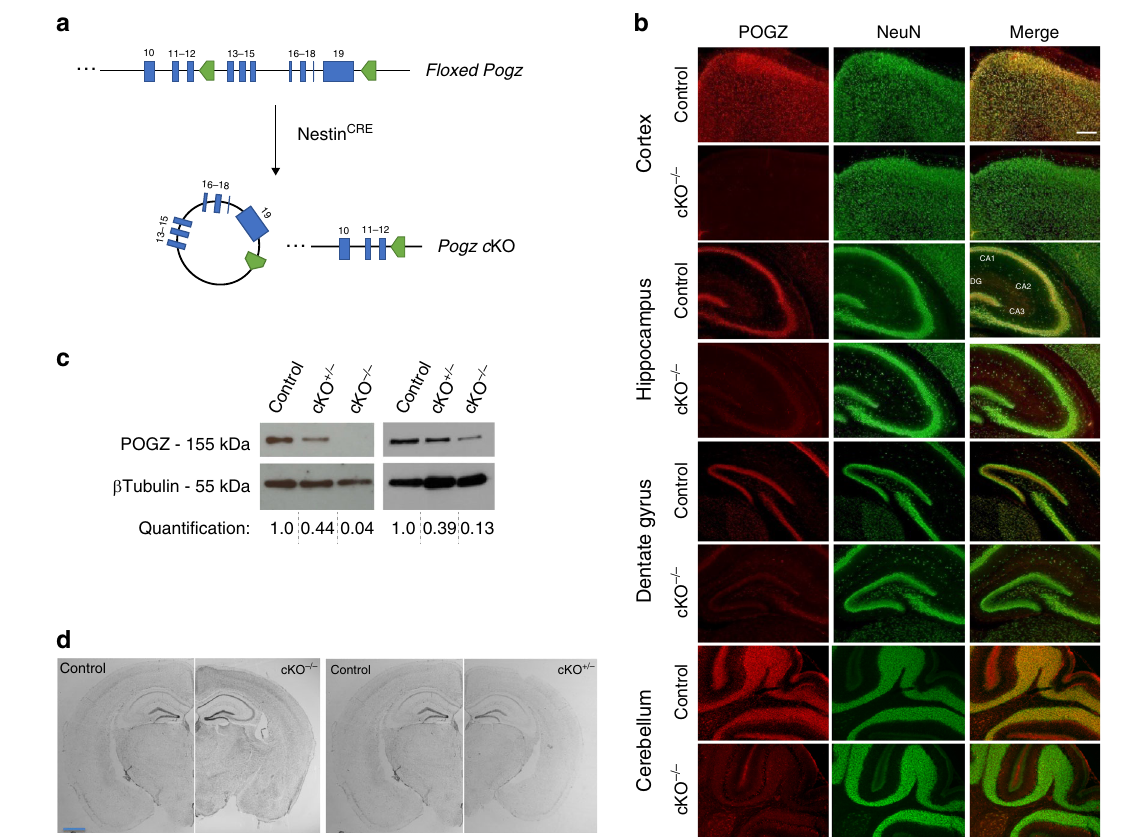
Fig. 1 Pogz de fi ciency mouse model does not exhibit gross defects in brain anatomy. a Schematic overview of Pogz knockout strategy. Pogz gene exons 13 − 19 (blue) were bounded by loxP sites (green). Pogz cKO + / − and Pogz cKO − / − mice were generated with a mutation restricted to the nervous system, by crossing fl oxed Pogz mice with Nestin Cre mice. b Immuno fl uorescence staining of Pogz cKO − / − and control mice brains (P11) using antibodies against POGZ (red) and NeuN (green). n = 3 control, 3 cKO − / − in one independent experiment. Scale bar = 100 μ m. c Western blots analysis of whole-cell lysates extracted from E14.5 mice cortices. n = 3 control, 3 cKO + / − , 3 cKO, in three independent experiments. d Nissl staining of coronal sections from Pogz cKO − / − and cKO + / − beside sections from control mice. n = 6 control, 6 cKO + / − , 3 cKO − / − in two independent experiments. Scale bar = 1